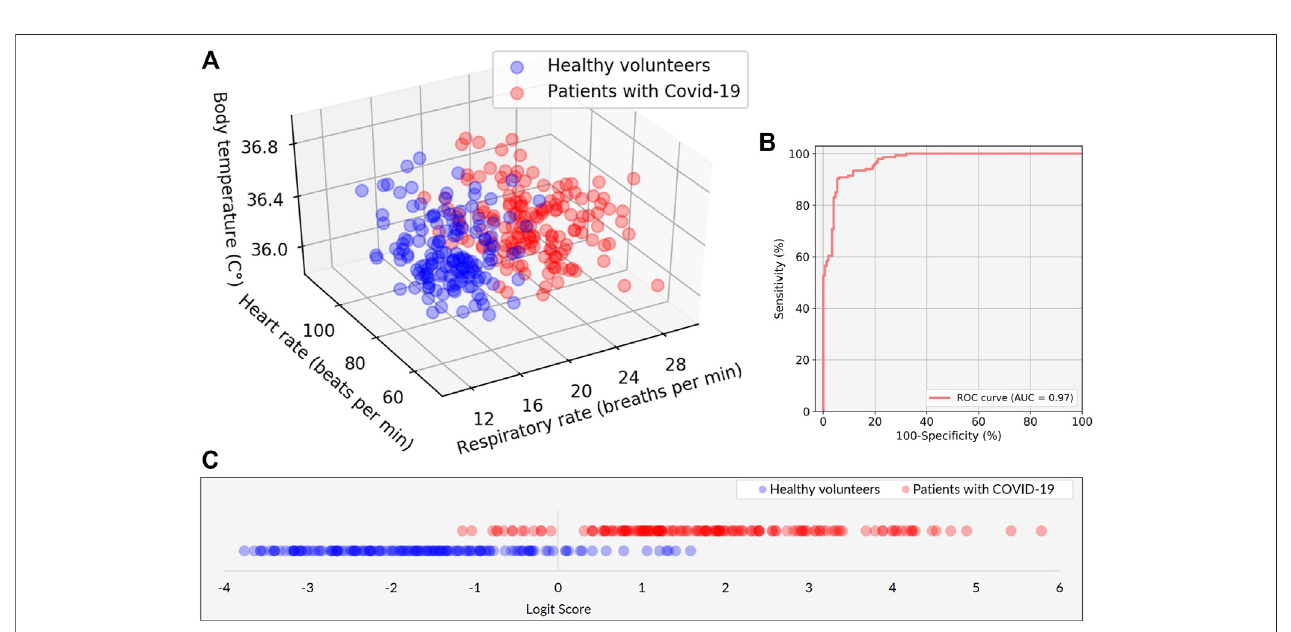
FIGURE 7 | Performance of the classi fi cation model in discriminating between patients with COVID-19 and healthy volunteers. (A) Scatter plots of the three explanatory variables of RR, HR, and BT in patients with COVID-19 (red) and healthy volunteers (blue). (B) The receiver operating characteristic (ROC) curve with area under the curve (AUC) of 0.97. (C) The classi fi cation result is represented by the logit scores (Logit Score ≥ 0 0 Suspected as COVID-19, Logit Score < 0 0 Healthy).